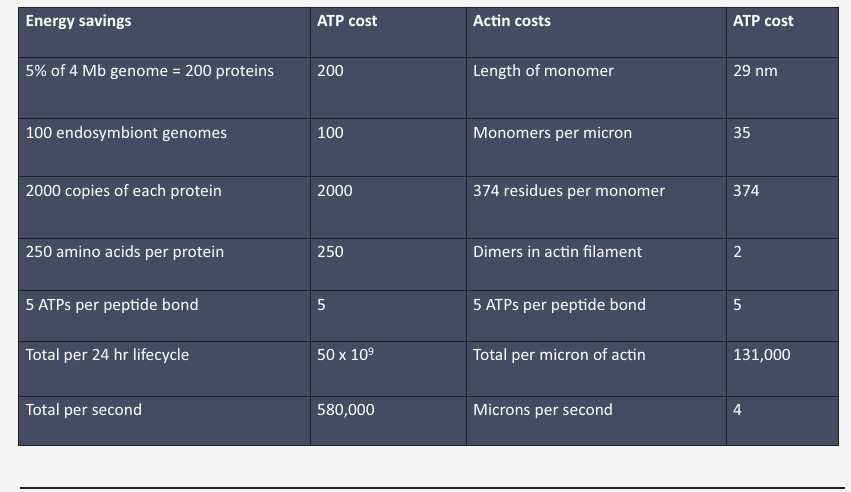
Figure 11. Table showing energy savings as a result of 5% gene loss from 100 endosymbionts (left column) and scale of advantage in terms of de novo synthesis of actin fi laments, the basis of the dynamic eukaryotic cytoskeleton. The energy savings from not needing to synthesise proteins from 200 genes in 100 endosymbionts equates to 580,000 ATPs per second, assuming a 24-hour lifecycle; in principle this is enough to power the de novo synthesis of 4 micometers of actin per second.